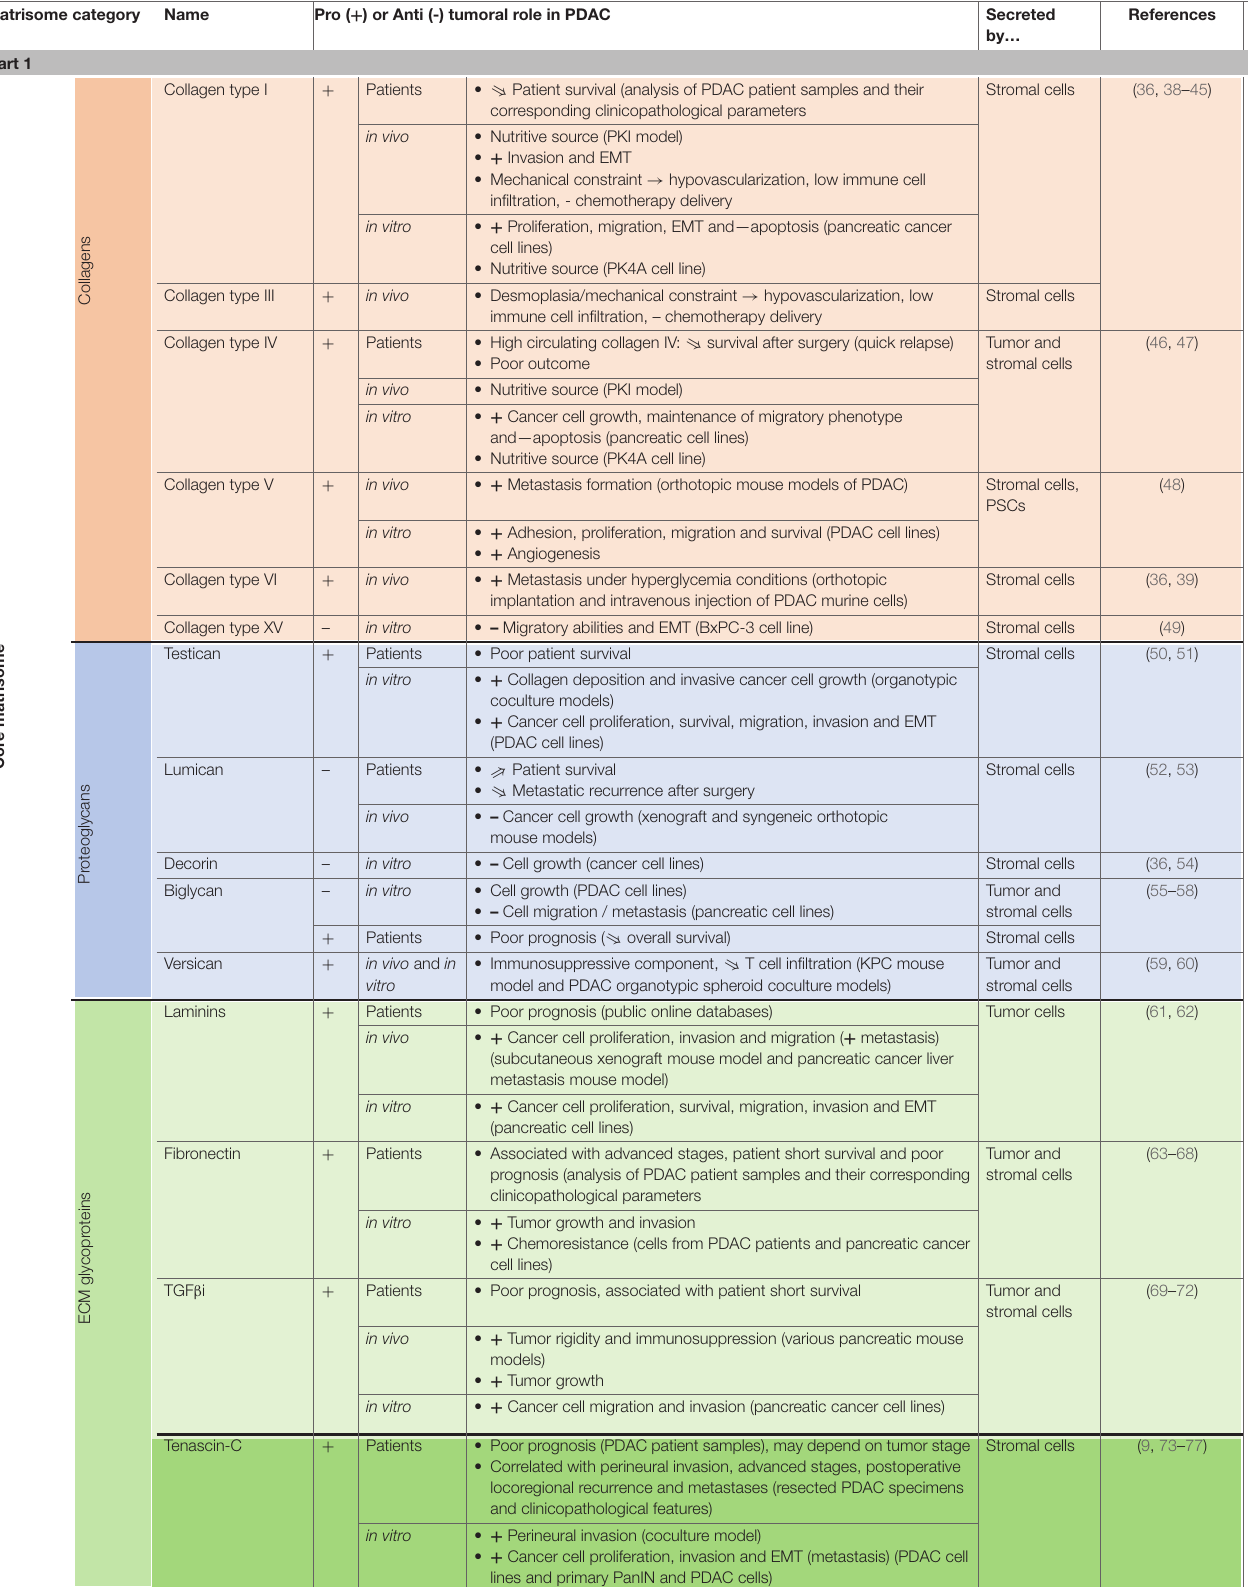
TABLE 1 | ECM proteins involved in PDAC, presented according to the matrisome